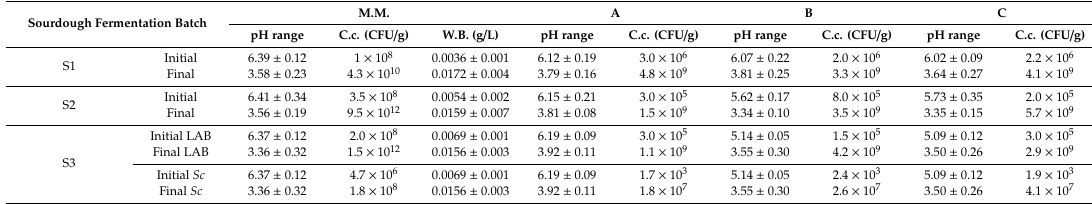
Table 1. Viability and pH of the sourdough